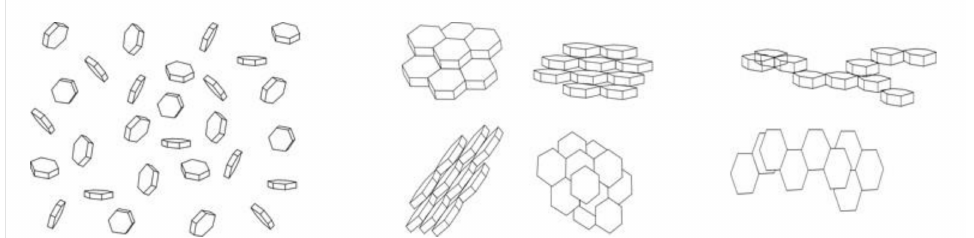
Figure 9. Sketch of various possible fillings of the copper matrix with graphite: left—entirely separated; center—clustered predominantly in c -direction; right—clustered predominantly via a -direction